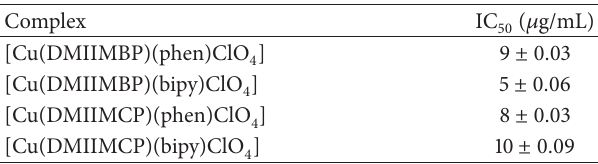
Table 9: IC range of Cu (II) complexes for HeLa 50